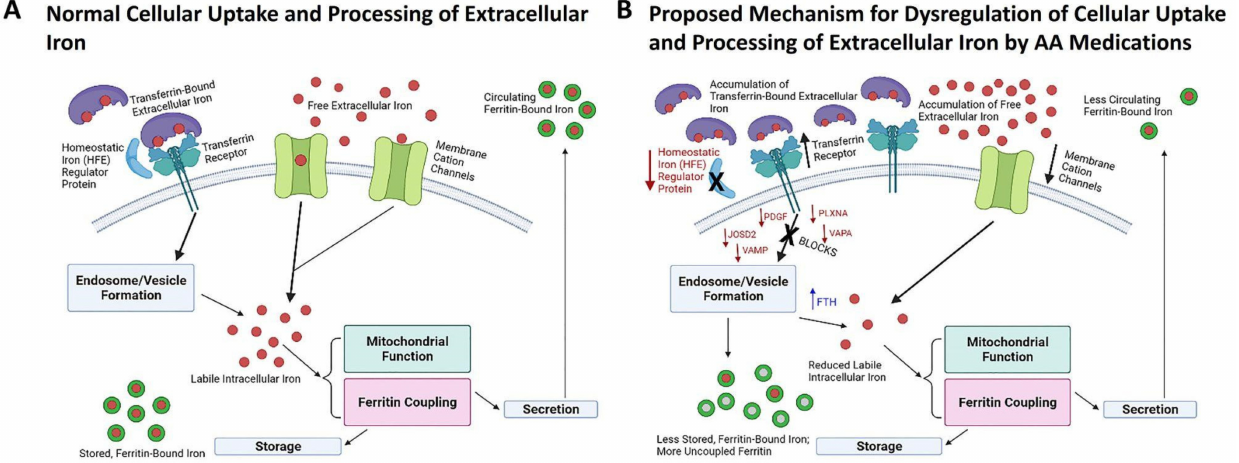
Figure 5. Proposed Mechanism for Impaired Cellular Iron Uptake Based on Differentially Expressed Traits. Panel ( A ) schematically describes processes for cellular iron uptake, storage and secretion into the circulatory system under physiologically normal conditions. AA-induced decreases of membrane cation channels, the transferrin co-receptor HFE and numerous proteins involved in endosome and vesicle formation suggests an inability to efficiently transport iron into cells and result in accumulation of extracellular iron in the liver (Panel ( B )). The reduction in intracellular iron would impair mitochondrial function and reduce the amount of available ferritin-bound iron within cells and in circulation.